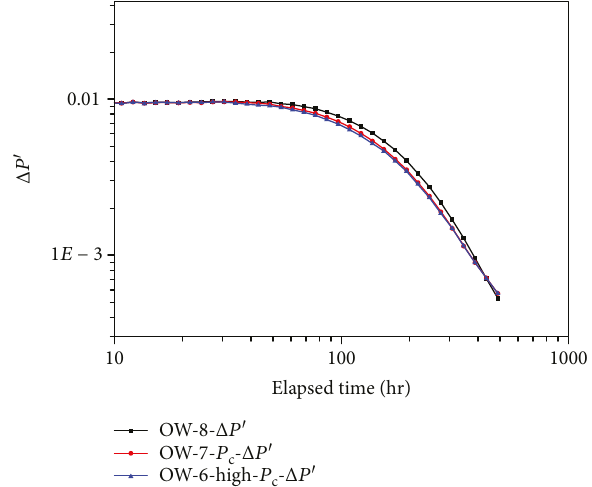
Figure 13: The log-log plot of drawdown in reservoir with constant pressure boundary. It shows that the transition zone pressure derivative of reservoir with capillary pressure goes down more than that without capillary pressure.